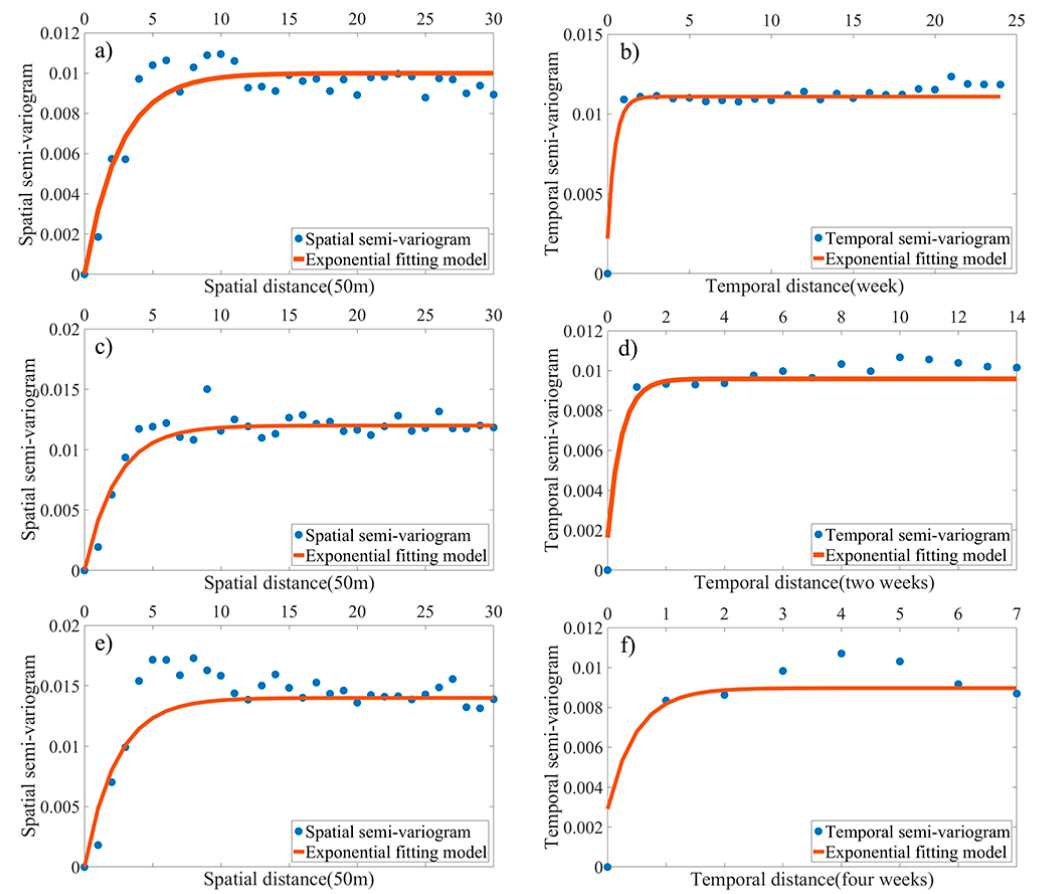
Figure 5. The spatial semi-variogram ( a , c , e ), temporal semi-variogram ( b , d , f ), and fitting models of the primary variable.